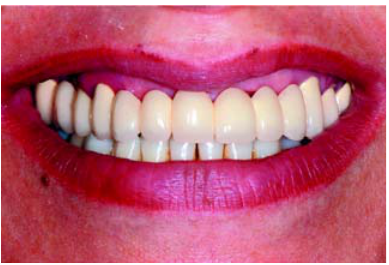
FIGURE 13- Final aspect of the ceramic